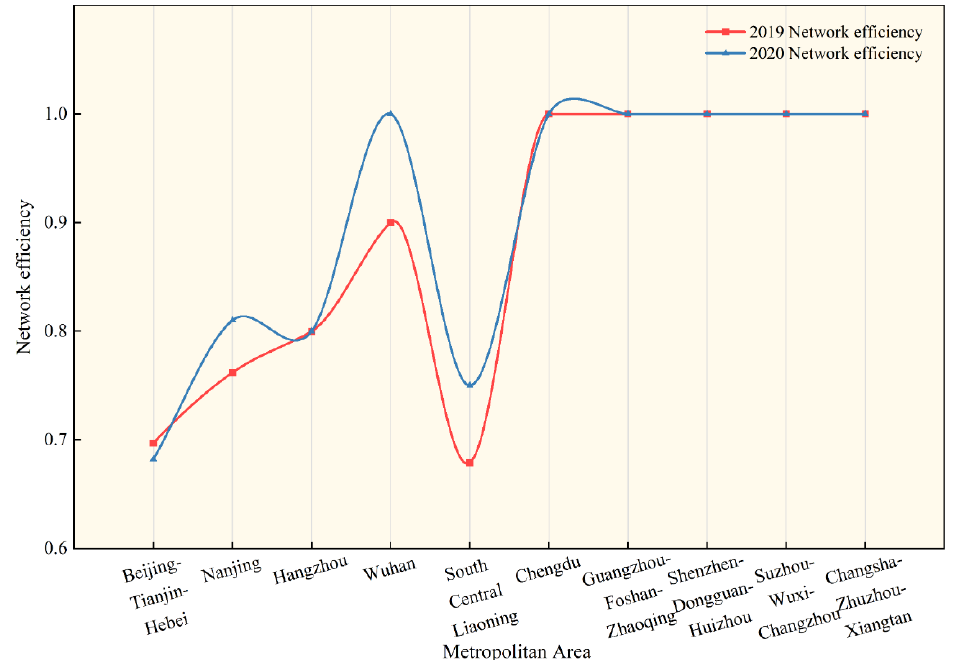
Figure 5. Network efficiency of PM 2.5 spatial correlation networks in ten metropolitan areas in 2019–